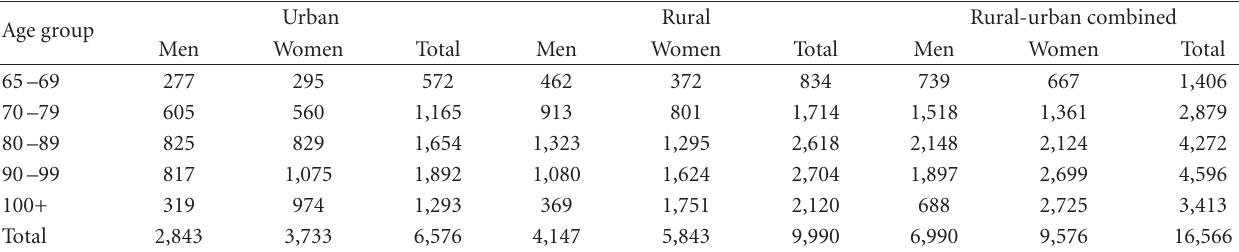
Table 1: Sample distributions of the elderly respondents in the CLHLS 2008-2009